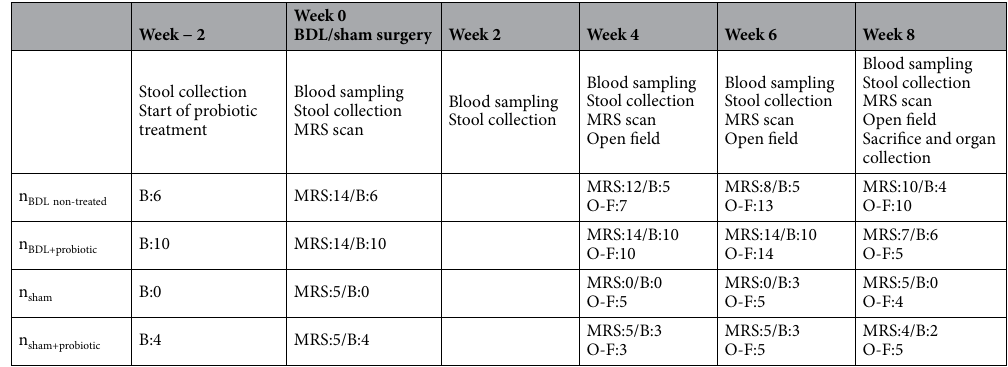
Table 1. Longitudinal study design. The number of rats (n) measured in every group are indicated for each week and each type of measures: ‘MRS’ stands for MRS scan, ‘B’ for the rats whose Bifidobacteria in the faeces were analysed, and ‘O-F’ for the rats who undergone open field test. Of note, for blood sampling we used the same number of rats as for the MRS scan and n sham = 5 at each week (data not included in the table for